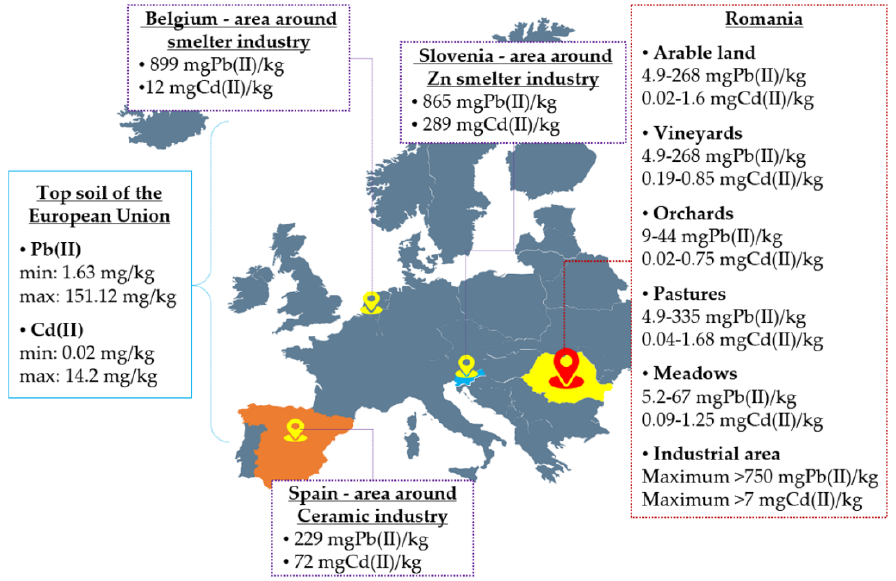
Figure 1. Cadmium and lead levels in soil in different areas of Europe and Romania (data in the Figure are selected from the sources [4–6]).